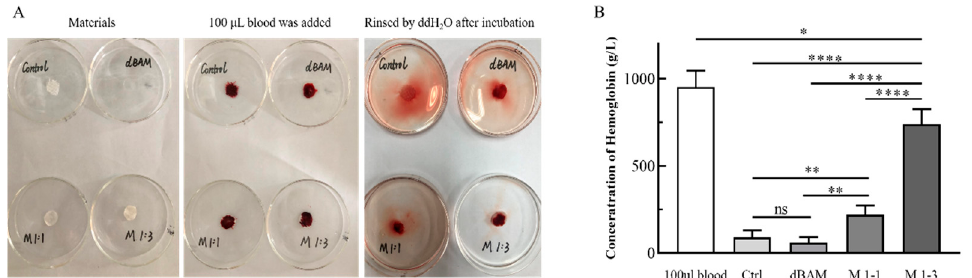
Figure 4. In vitro blood coagulation test, ( A ) the photographs of the blood-clotting process, ( B ) the concentration of hemoglobin in the blood clots on the materials (ns: p > 0.05; *: p < 0.05; **: p < 0.01; ****: p < 0.0001).